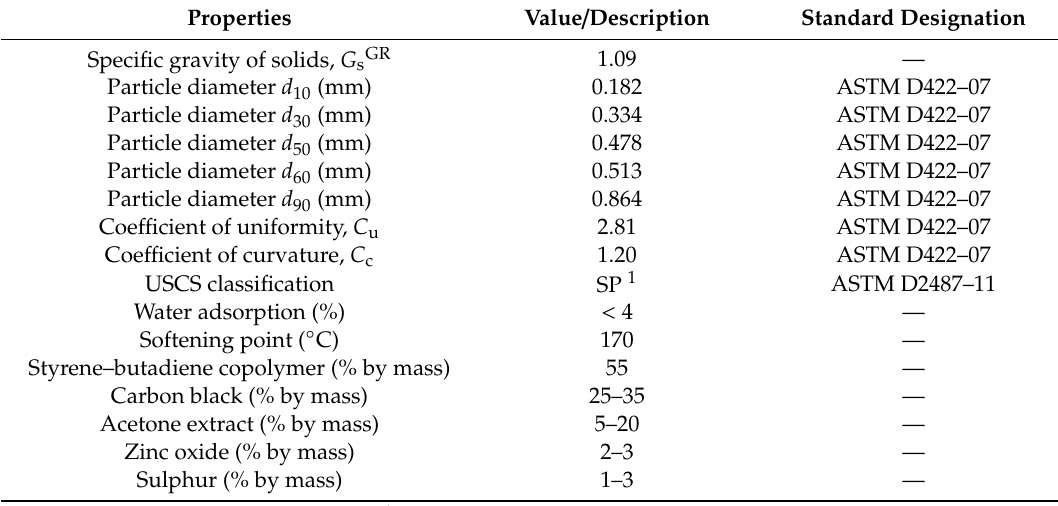
Table 2. Physical properties and chemical composition of